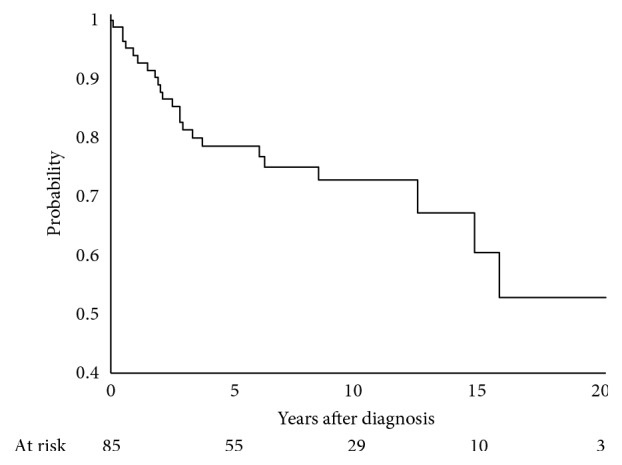
Disease-free survival at 5 years, 78.6% (95% CI: 67.8–86.1).